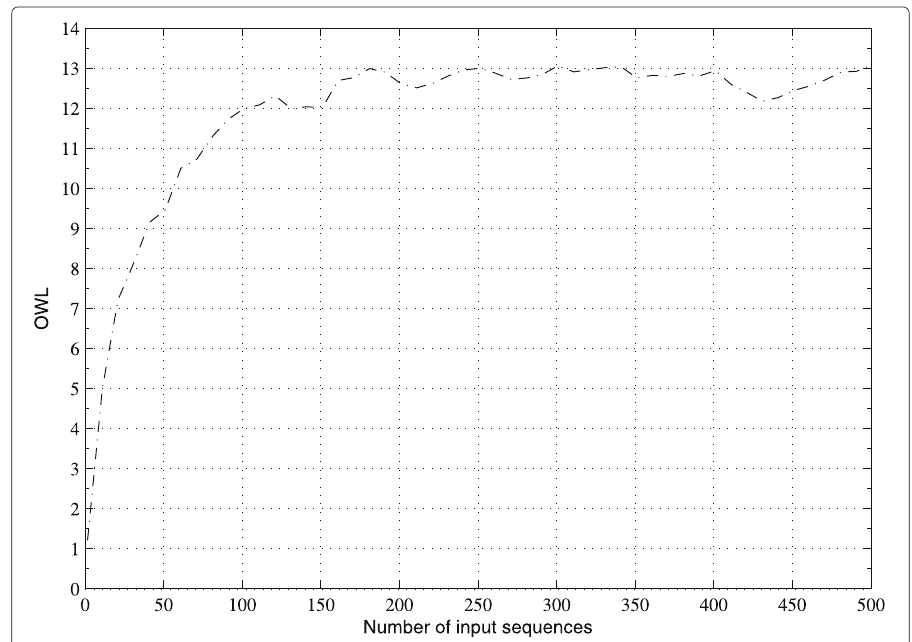
Fig. 3 OWL evolution curve for VOWL-BED at SNR = 15